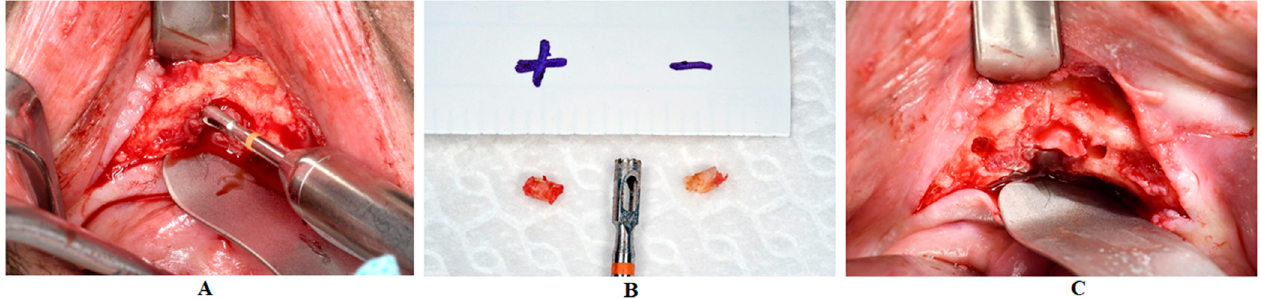
Figure 2. Surgical site of a patient suffering from ORN. ( A ) Illustrates the collection of a necrotic bone sample with a rotating trepan drill. ( B ) Vital bone sample (+) and necrotic bone sample ( − ). ( C ) Surgical site after the collection of two bone samples (vital and necrotic).